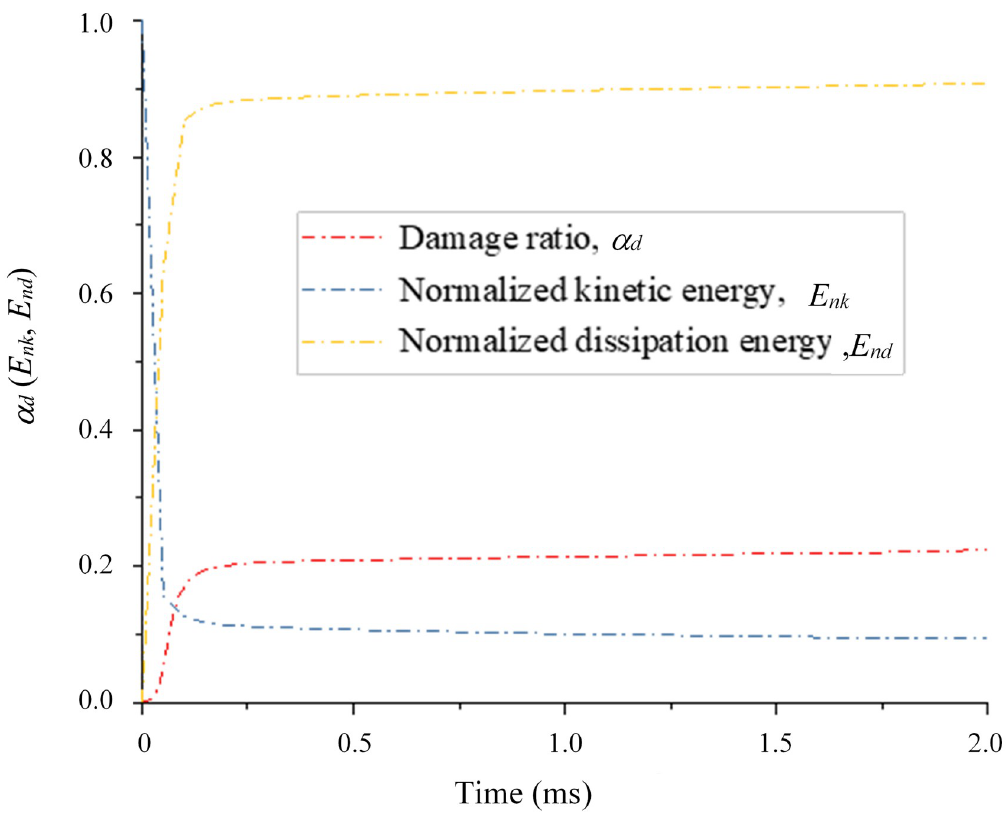
Fig 13. Evolution of the damage ratio ( α d ), normalized kinetic energy ( E nk ) and normalized dissipation energy ( E nd ) with time ( v = 40 0